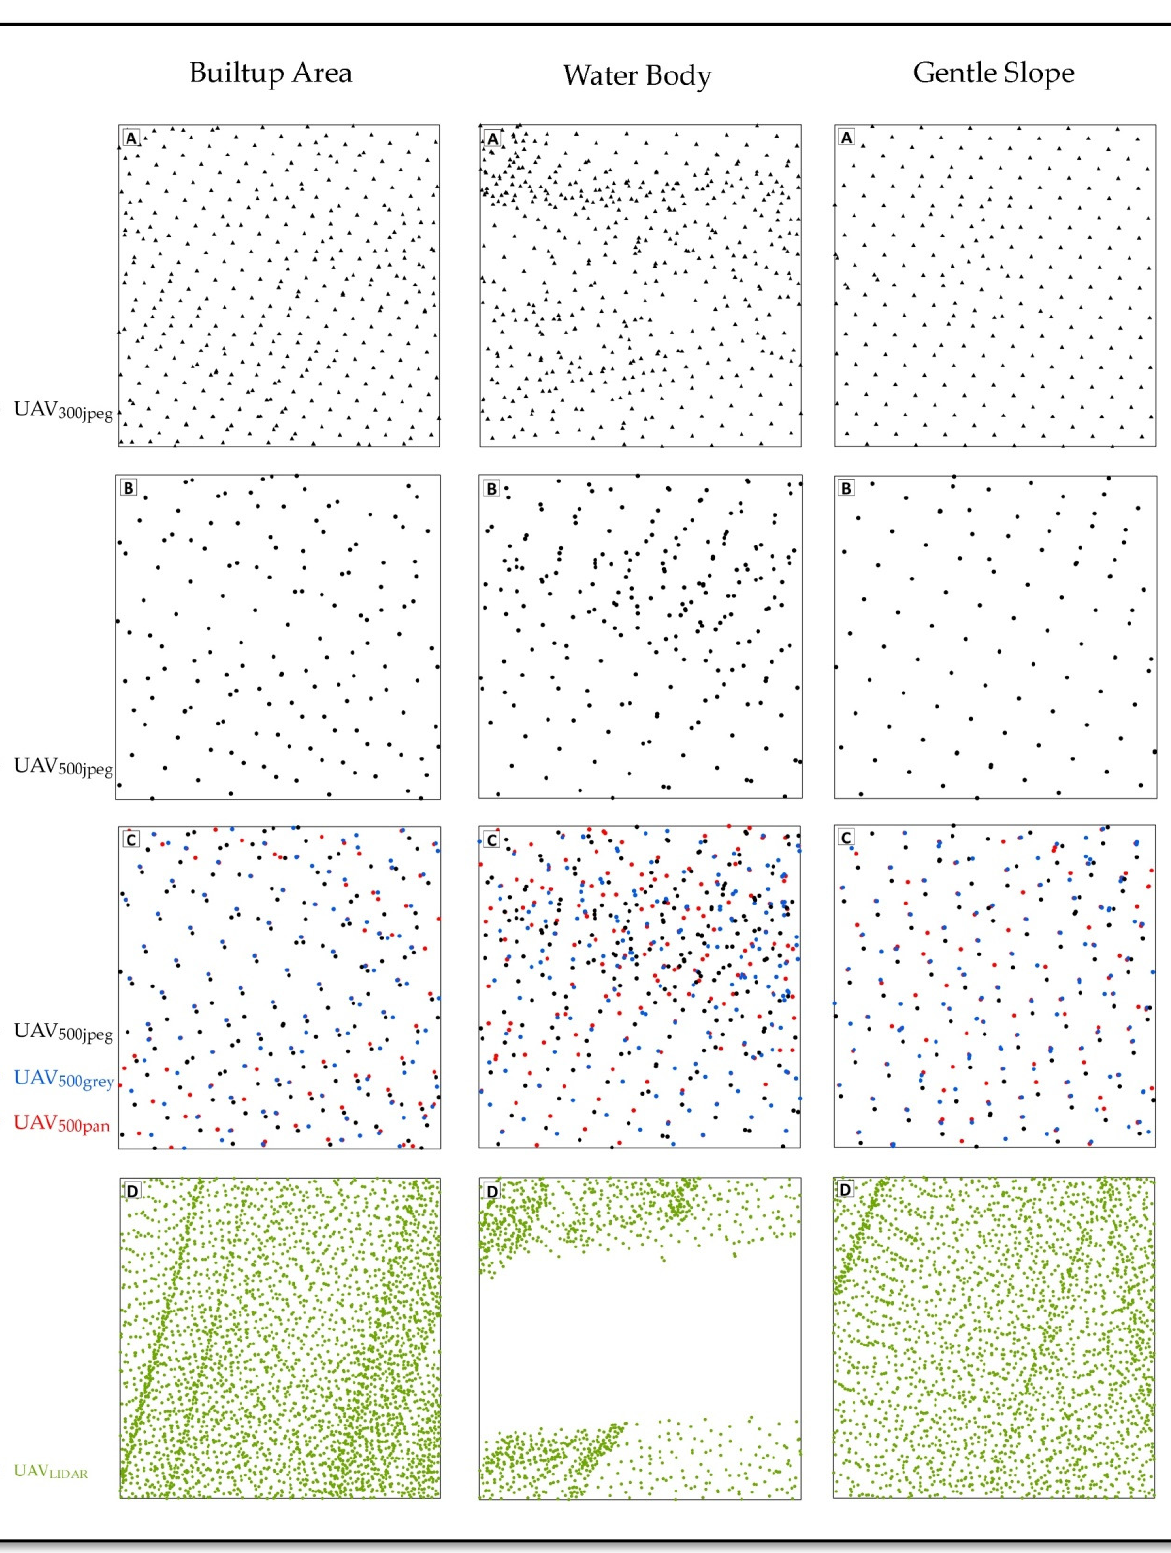
Figure 6. Point cloud distribution at certain area. ( A ) Showing UAV 300jpeg point cloud, ( B ) Showing UAV 500jpeg point cloud, ( C ) Showing increased number of point cloud after image enhancement UAV 500jpeg (black points), UAV 500grey (blue points) and UAV 500pan (red points) and ( D ) Showing UAV LIDAR point cloud.